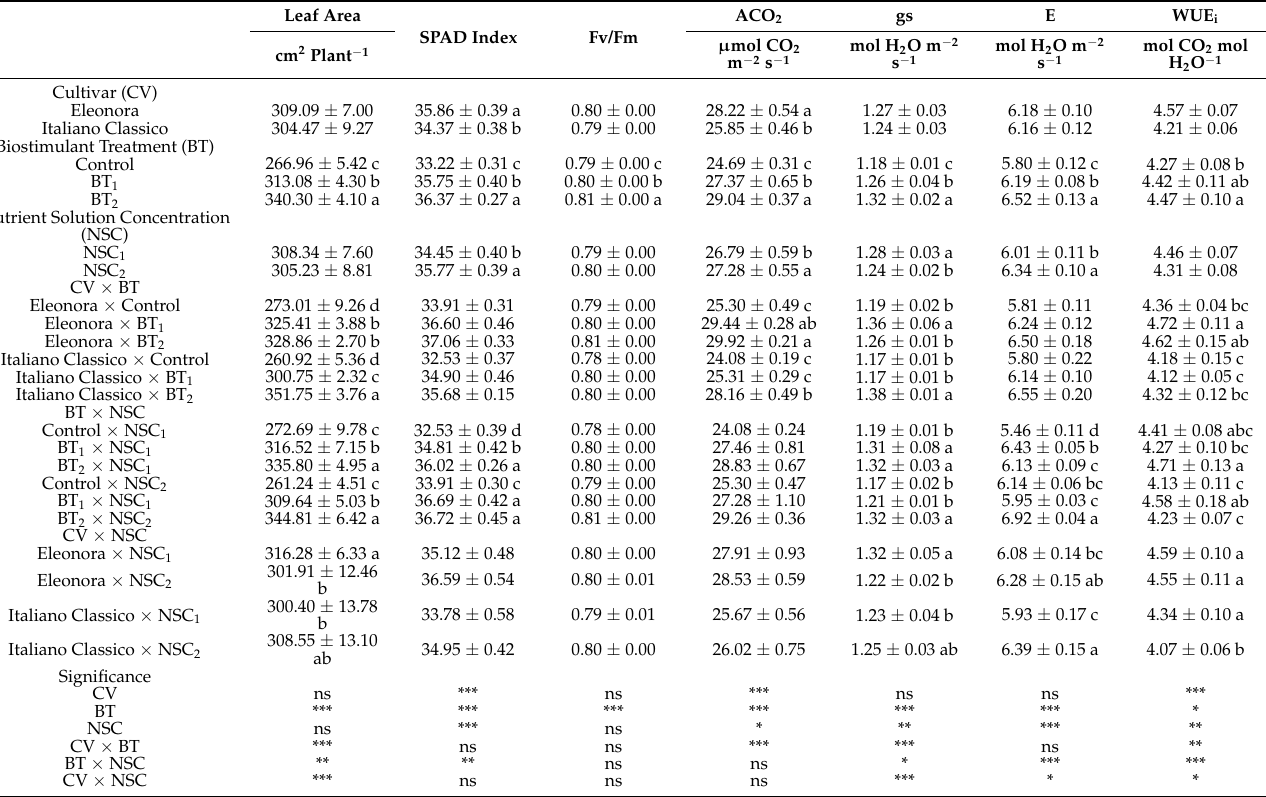
Table 2. Analysis of variance and mean comparisons for leaf area, SPAD index, Fv/fm, net CO 2 assimilation rate (ACO 2 ), stomatal conductance (gs), transpiration (E), and instantaneous water use efficiency (WUE) of Eleonora and Italiano Classico basil cultivars grown in floating raft system under two different nutrient solutions treatments and two rates of biostimulant